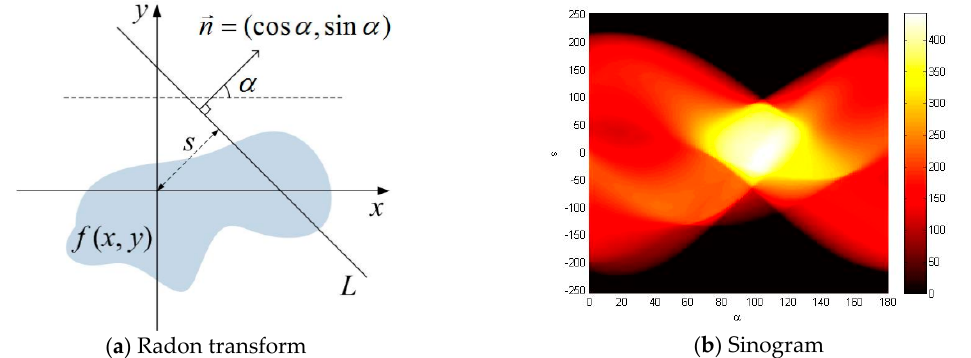
Figure 1. The concept of the Radon transform and sinogram. ( a ) A function f ( x , y ) on the 2D Euclidean space R 2 is transformed into a function on a new 2D space with α and s which defines the straight line L in R 2 . ( b ) The result of applying the Radon transform to f ( x , y ) is called sinogram .